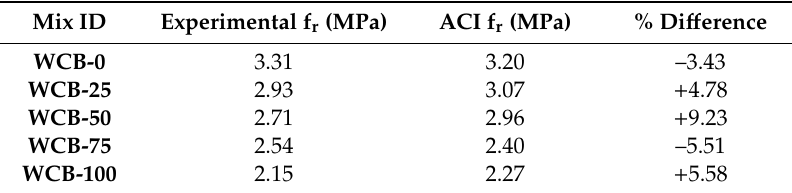
Table 6. Comparison between flexural strength —f r (MPa).